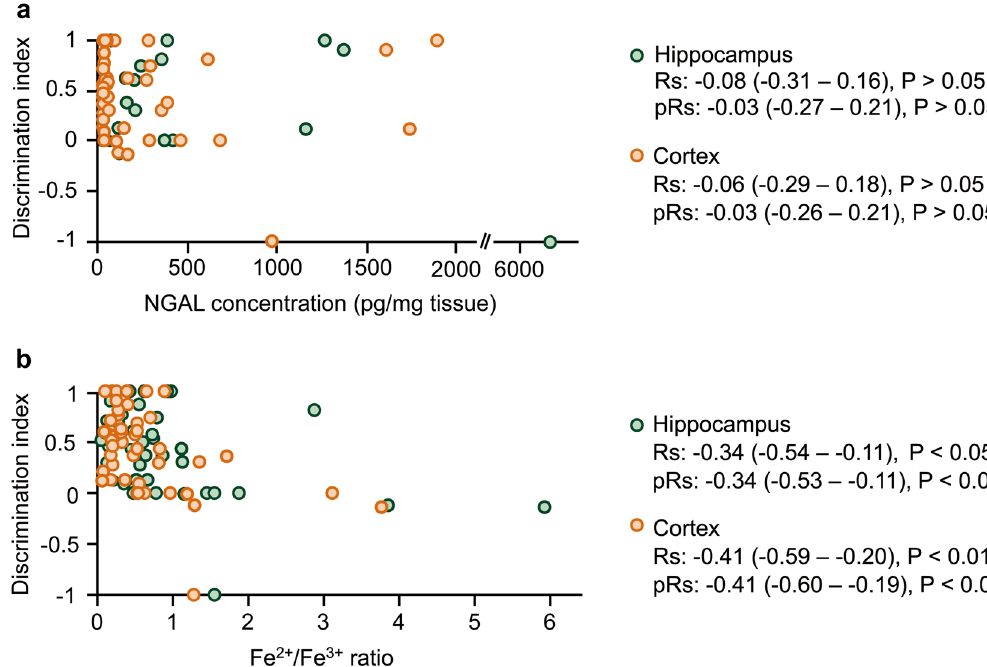
Figure 5. Object discrimination ability was negatively correlated with the Fe 2+ /Fe 3+ ratio in the hippocampus and cortex. ( a ) Spearman correlation (Rs) and partial correlation (pRs) analysis revealed no significant relationship between the discrimination index and the hippocampal and cortical NGAL levels. ( b ) The Fe 2+ /Fe 3+ ratio in the hippocampus and cortex exhibited a significant negative correlation with the discrimination index. The partial correlation analysis was controlled for Fe 2+ /Fe 3+ ratio ( a ) or NGAL level ( b ). The coefficients are presented with (95% CI). n =